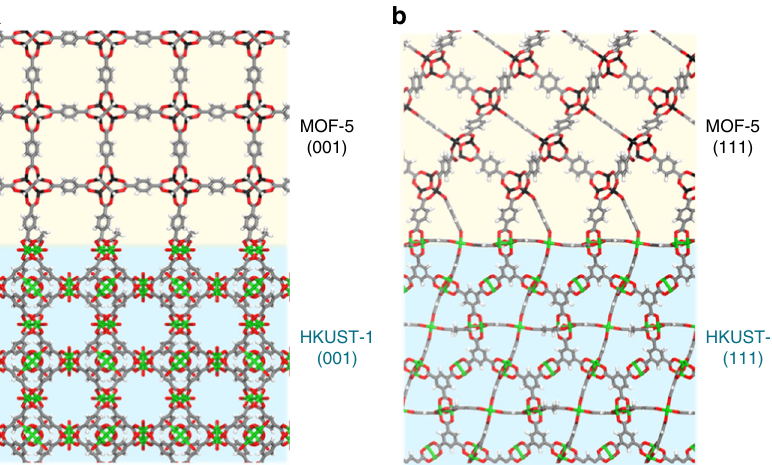
Fig. 2 Computational structural models for the HKUST-1/MOF-5 system. a HKUST-1(001)/MOF-5(001) and b HKUST-1(111)/MOF-5(111). The yellow region indicates the space for MOF-5 phase and green region for the HKUST-1